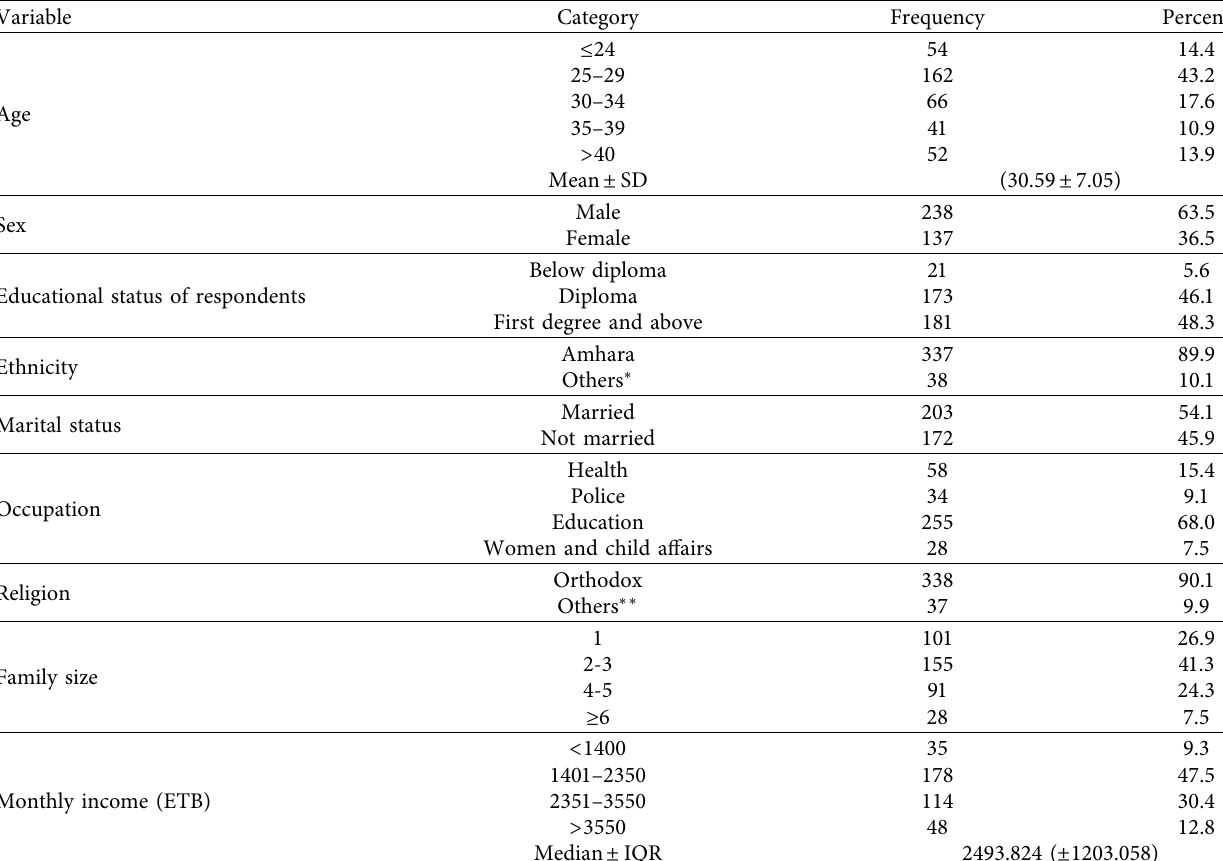
Table 1: Socio-demographic and economic characteristics of the government employees in Muja town, northeast Ethiopia, 2016 ( n � 375). Variable